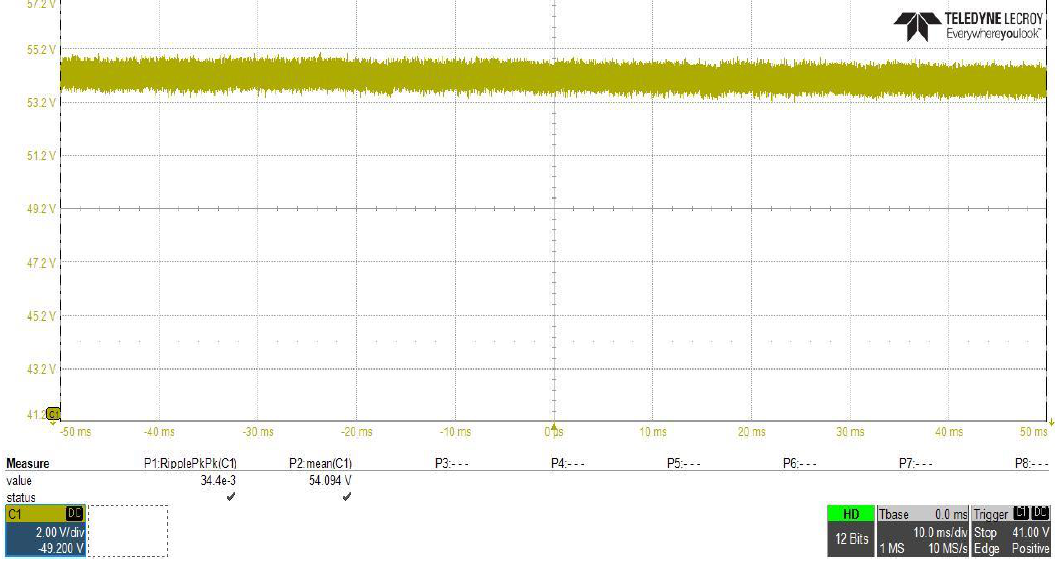
Figure 23. DC – DC converter stage output voltage ripple peak to peak measurement at V in = 400 V. Figure 23. DC–DC converter stage output voltage ripple peak to peak measurement at V in = 400